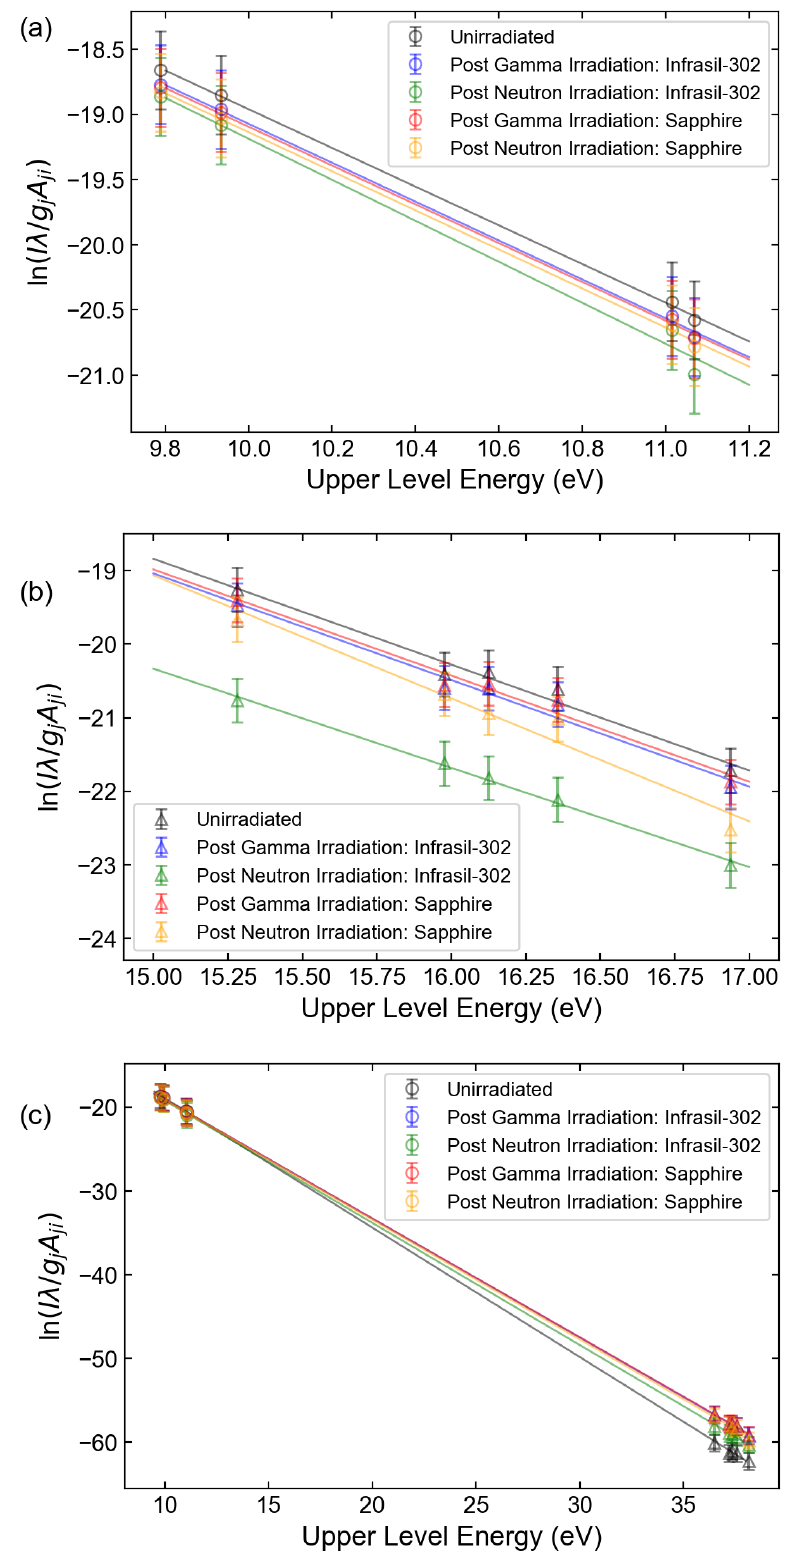
Figure 6. Boltzmann plots using the spectral data both before and after accounting for radiation- induced attenuation for ( a ) Xe I lines only, ( b ) Xe II lines only, and ( c ) both groups combined using the Saha–Boltzmann